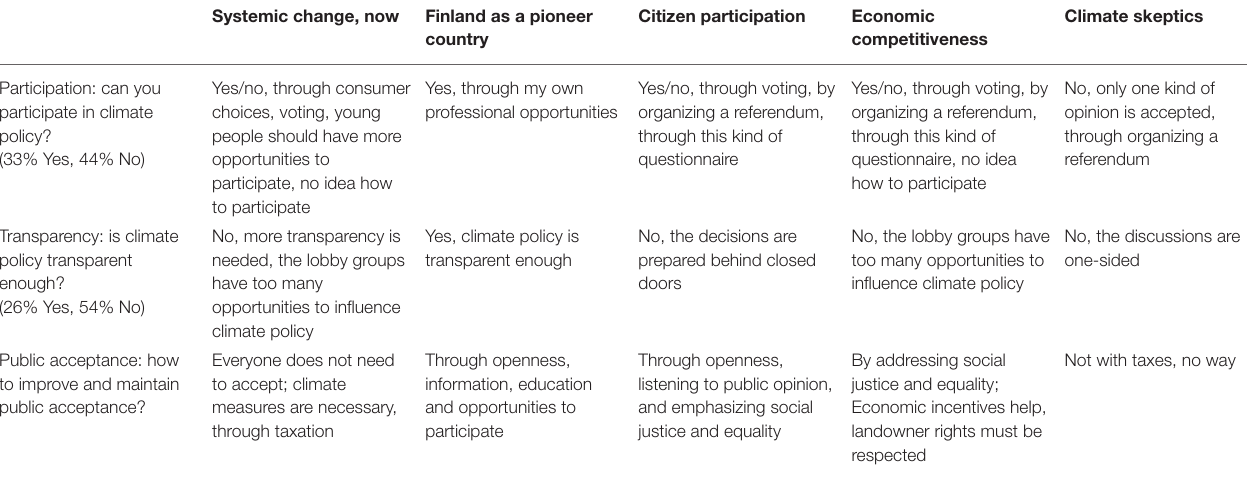
TABLE 1 | The results of the theme analysis ranged from citizens who supported additional climate change initiatives to climate skeptics. Systemic change,